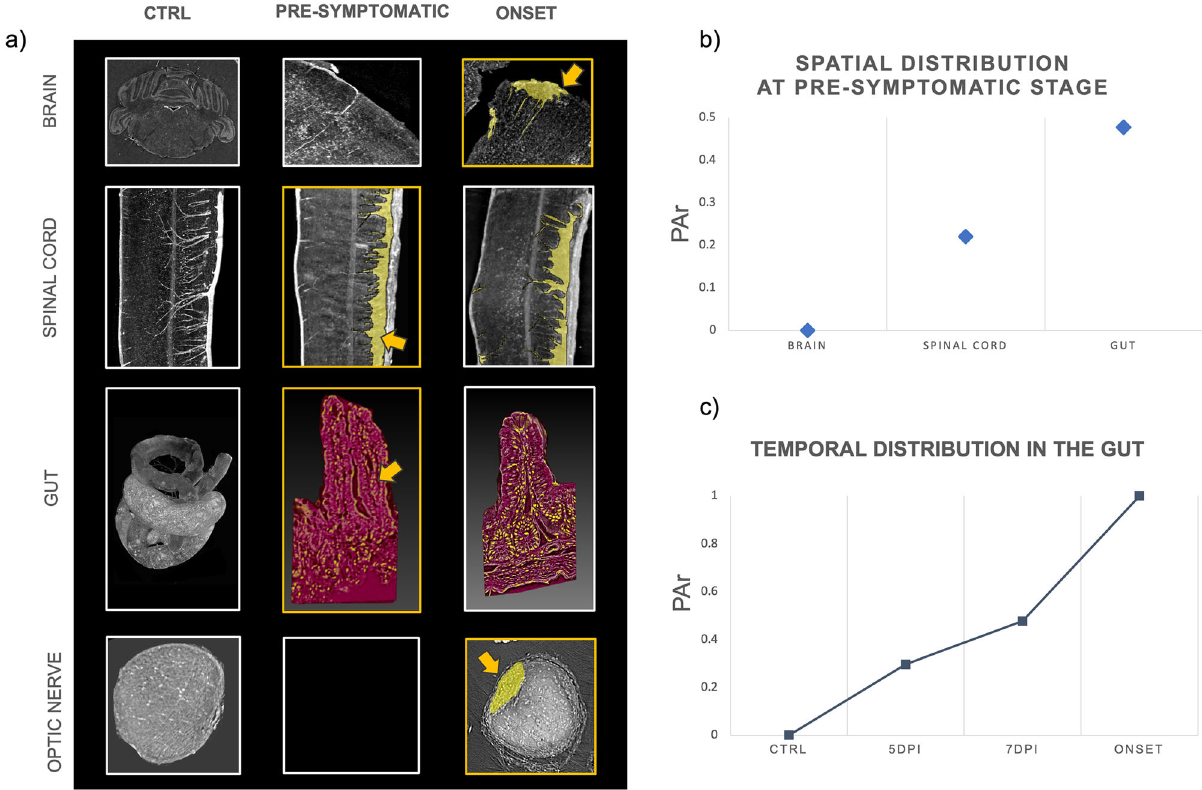
Fig. 7 Multi-organ investigation and temporal assessment of imaging markers at early stages. The fi gure shows the results of the multi-organ investigation and temporal assessment of experimental autoimmune encephalomyelitis (EAE) imaging markers at early stages. a Representative X-ray phase contrast tomography (XPCT) images and/or rendering of the multi-organ investigation of EAE at pre-symptomatic stage and at the onset. The arrows highlight the presence of alterations. In the brain, the degenerative process involves vascularization as well as in the spinal cord. In the gut and optic nerve, we detected imaging alteration through an increase in cellular in fi ltrates. The image for the optic nerve at the pre-symptomatic stage was not included because samples at this stage were not available. b Graphical representation of spatial distribution of PAr at 7 days post induction (dpi) ( n = 2 samples for brain, n = 3 for spinal cord, n = 2 for gut). Optic nerve results were not included because samples were not available for this time point. c Distribution over time of the appearance of imaging markers for the gut in EAE-induced mice (20 villi per n = 2 mice per time point). Clinical EAE score at the onset = 1.5, 3, 1.5,